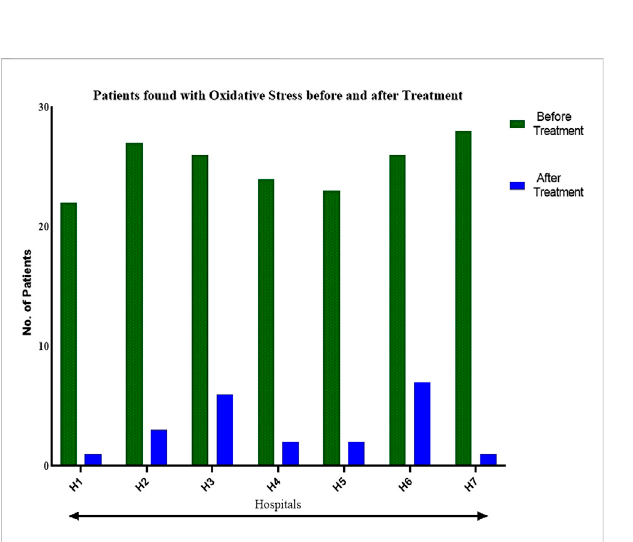
FIGURE 4 A comparison of pre-and post-treatment outcomes of Dexmedetomidine on programmed cell death: